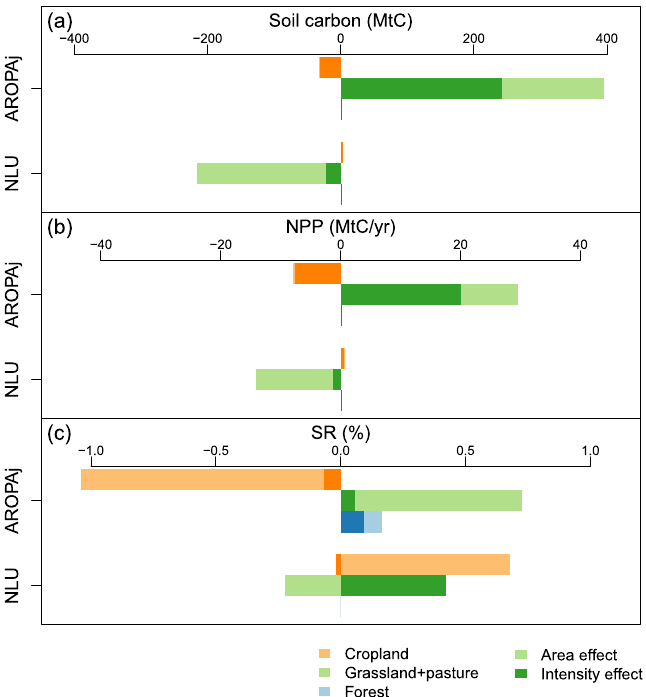
Figure 5. Breakdown of ( a ) soil carbon, ( b ) net primary production (NPP), and ( c ) species richness (SR) change from present-day ( Baseline ) due to “area effect” and “intensity effect” at the EU scale. Colors (orange, green and blue) distinguish the different land-uses (cropland, grassland/pasture and forest). Dark color shows the “intensity effect” and light color shows the “area effect”. Breakdown of changes ( Halving-N – Baseline ) are computed for both AROPAj and NLU scenarios. The mean numbers are given in Tables S1 and S2. The “area effect” means the change in C sequestration/NPP/SR associated with a change in the land-use area and the “Intensity effect” means the effect of production reallocation on C sequestration/NPP, and the effect of a change in land-use intensity (crop yield or stock rate) on biodiversity. This figure is created using software R version 3.6.0 (https:// www.r- proje ct.